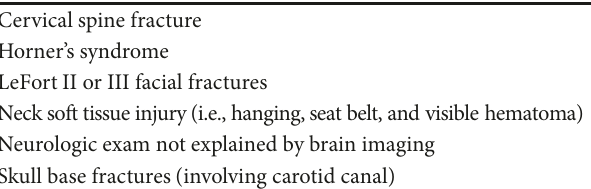
Table 1: Memphis criteria screening for BCVI. Cervical spine fracture Horner’s